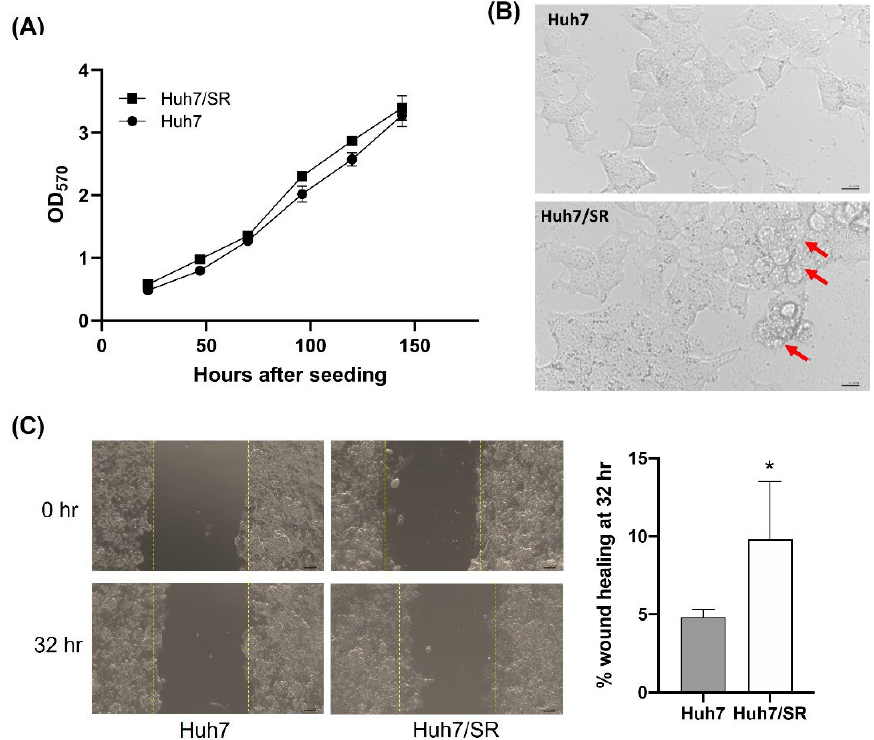
Figure 1. Comparison of cell growth rate and migratory ability between Huh7 and Huh7/SR cells. ( A ) Huh7 and Huh7/SR cells had similar growth rates, as shown by the MTT assay. ( B ) Cell morphology of Huh7 and Huh7/SR cells were observed by a light microscope. Red arrows point out the vesicle-like structures. ( C ) Wound healing assay was performed to determine the cellular migratory ability. Huh7/SR cells showed significantly higher migratory ability than Huh7 cells. * p < 0.05.